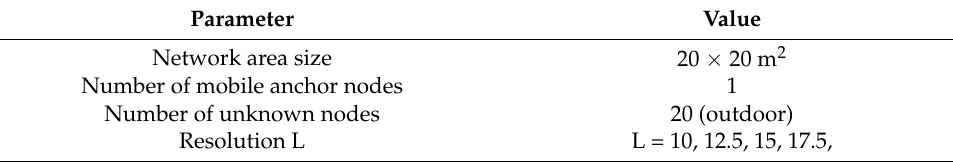
Table 3. Experimental